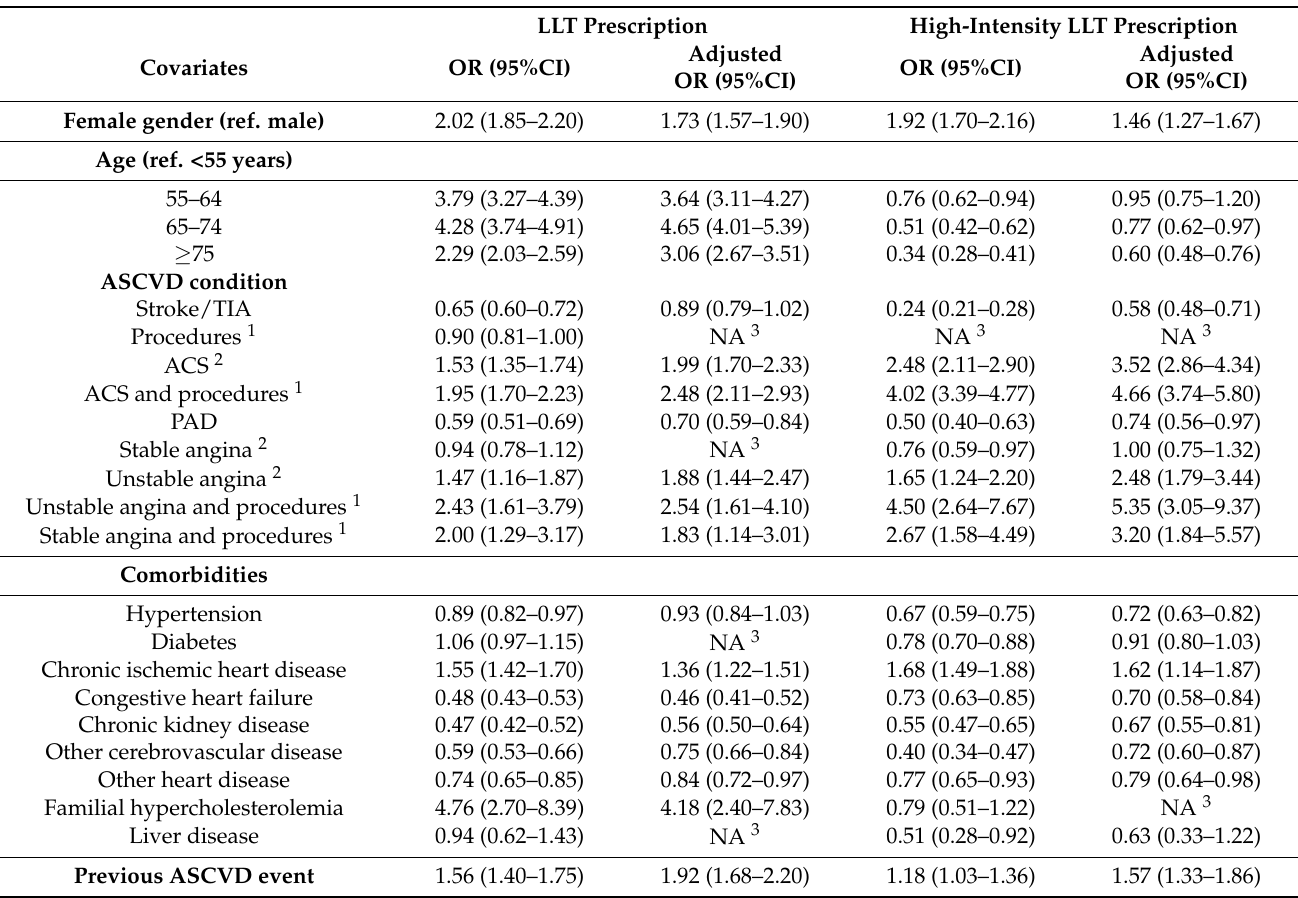
Table 2. Demographic and clinical factors associated with LLT prescribing (ref. not prescribing) and with high-intensity LLT prescribing (ref. low-/moderate-intensity LLT